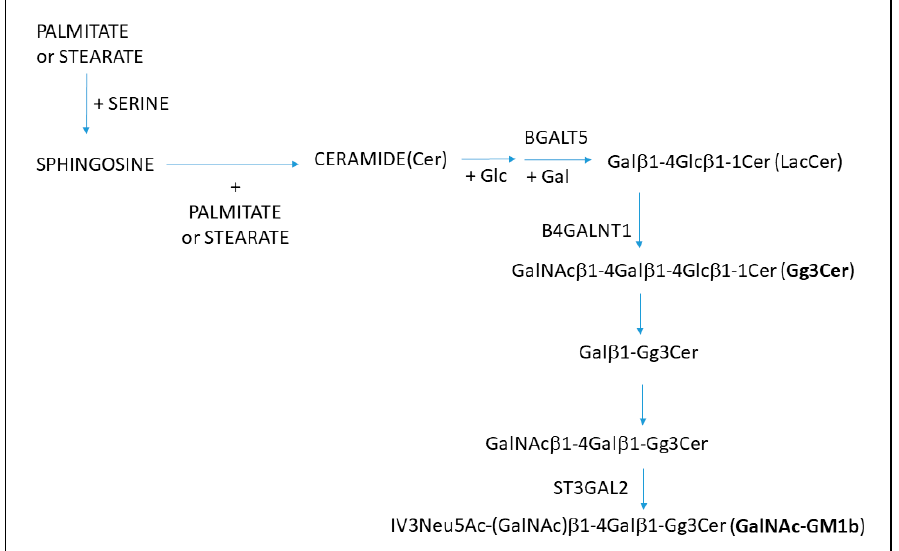
Figure 10. Pathway of Gg3Cer and GalNAc-GM1b glycosphingolipid synthesis in MDA-MB-231 cells. The designation of the glycosphingolipids and their core structures follow the IUPAC-IUB recommendations [32]. Only transferases B4GALNT1, B4GALT5 and ST3GAL2, which are among the most consistently malignancy-associated enzymes [44], are marked at corresponding steps of synthesis. The relative concentrations of the